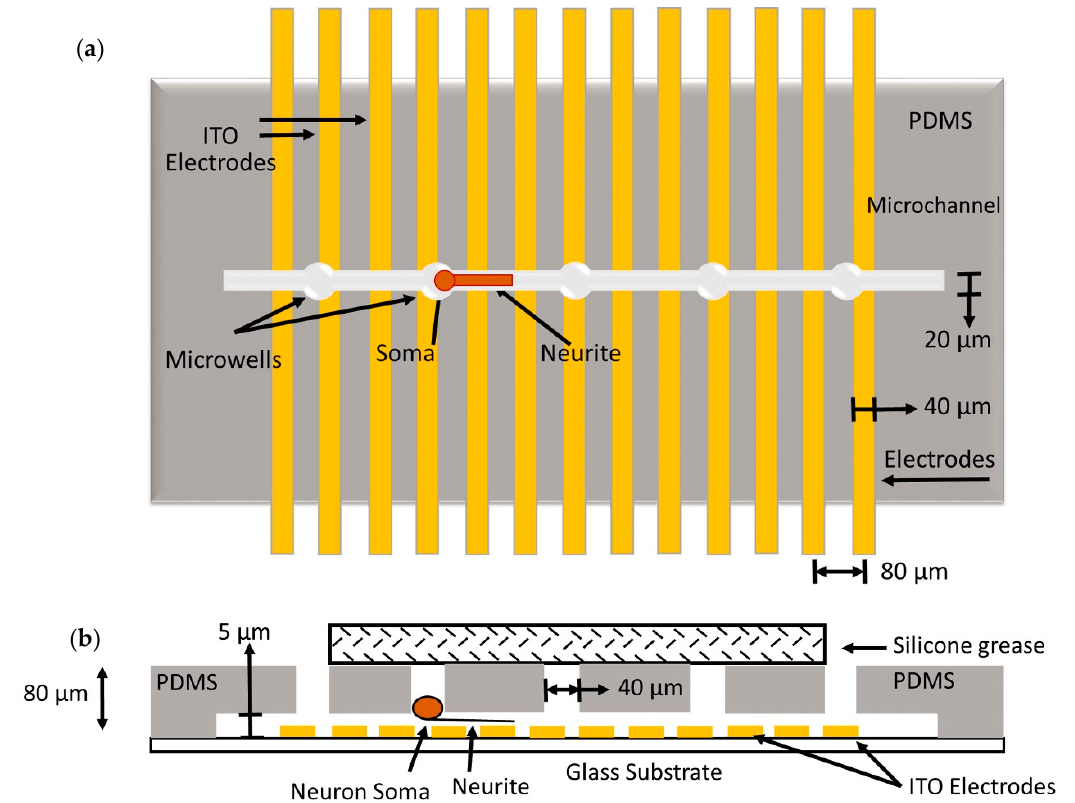
Figure 18. Schematic showing a microelectrode device fabricated by photolithography with microwells and microchannels on a planar multielectrode array, in which neurons were individually positioned in microwells, view from top ( a ) and side ( b ). Redrawn from [188].